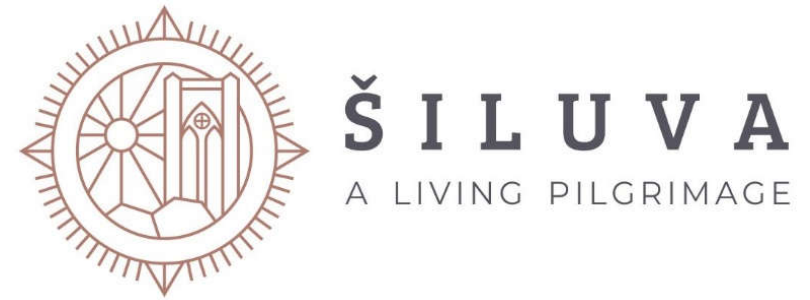
Figure 6. Šiluva A Living Pilgrimage logo.